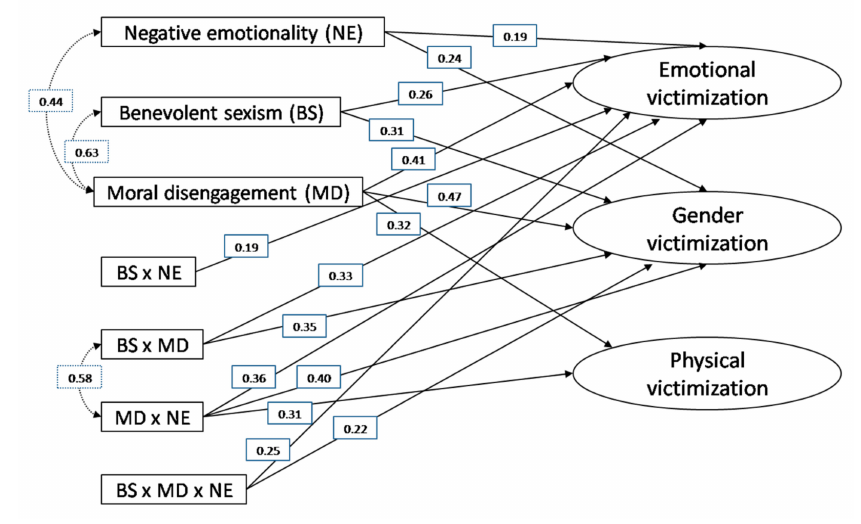
Figure 1. Final Structural